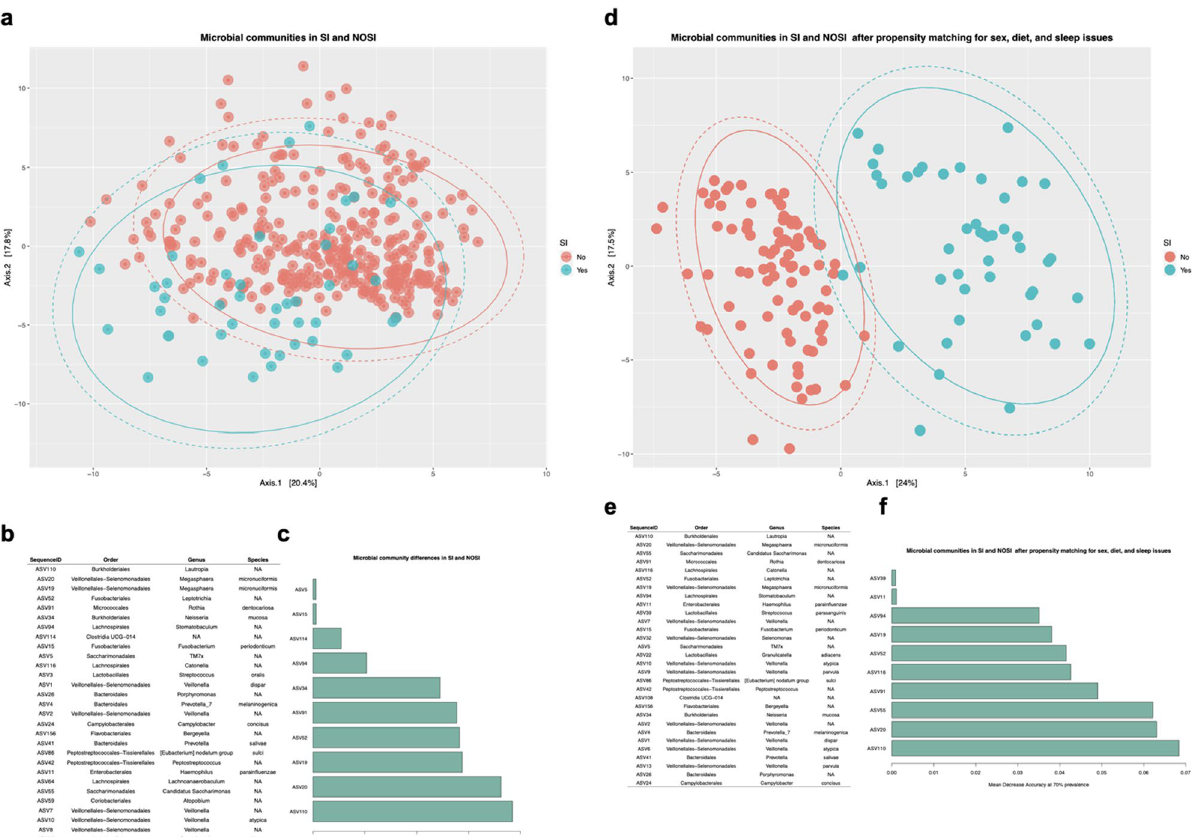
Figure 2. Microbial community prevalence differences in the full cohort (SI vs. NOSI) and in the sleep- restricted cohort (SI sleep vs. NOSI sleep ). ( a ) Principal coordinates analysis of amplicon sequence variants (ASVs) present at 70% prevalence in either the SI (N = 47) or NOSI (N = 325) in the full dataset. ( b ) Silva taxonomy of the top 30 ASVs contributing to the classification for SI versus NOSI. ( c ) Mean decrease accuracy of the top 10 ASVs for the model. ( d ) Principal coordinates analysis of amplicon sequence variants (ASVs) present at 70% prevalence in either the SI (N = 47) or matched NOSI (N = 94) subjects who were selected by propensity score matching on sex, diet factors, and sleep issues. In this analysis, microbial communities were assessed after removal of the thirteen depressed individuals from the matched NOSI cohort. ( e ) Silva taxonomy of the top 30 ASVs contributing to the classification of SI vs. NOSI after propensity matching. ( f ) Mean decrease accuracy of the top 10 ASVs for the model. Full sequences for the ASVs are provided in Supplementary Table